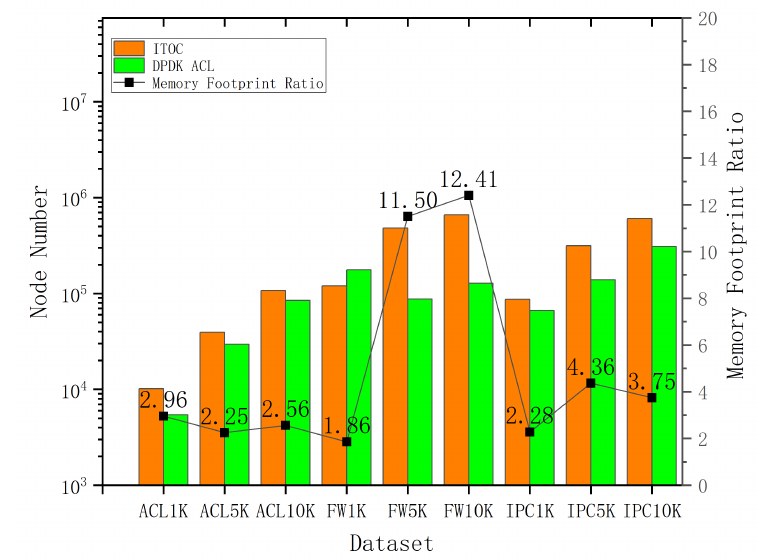
Figure 7. Node number and memory